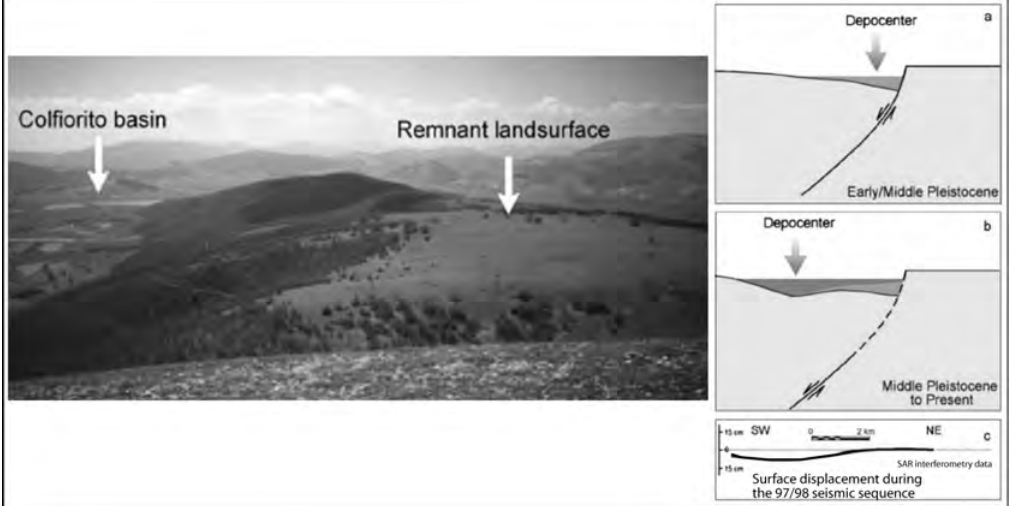
Fig. 15. View of a remnant land surface carved in carbonate bedrock above the Colfiorito basin (Messina et al ., 2002). To the right is a two-part scheme for the evolution of the Colfiorito basin. Below that is the 1997 surface coseismic deformation as inferred from DinSAR (Messina et al. , 2002). The maximum deformation (lowering) coincides with the deepest depocenter of the